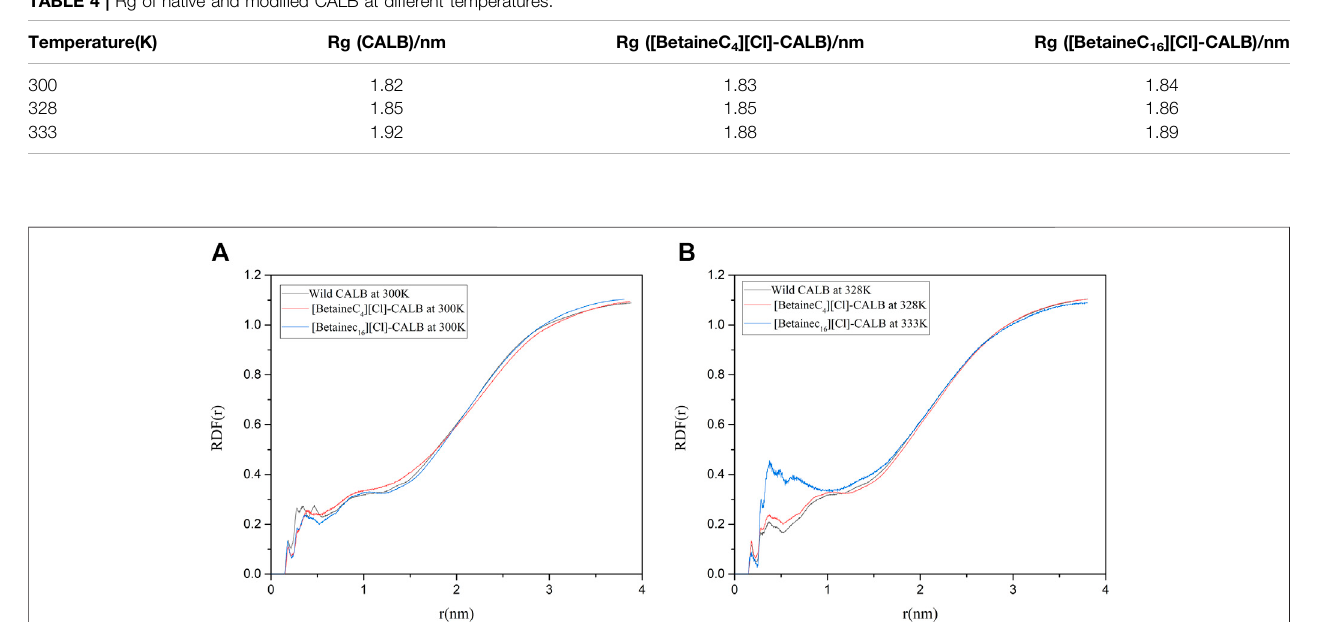
Frontiers in Bioengineering and Biotechnology |